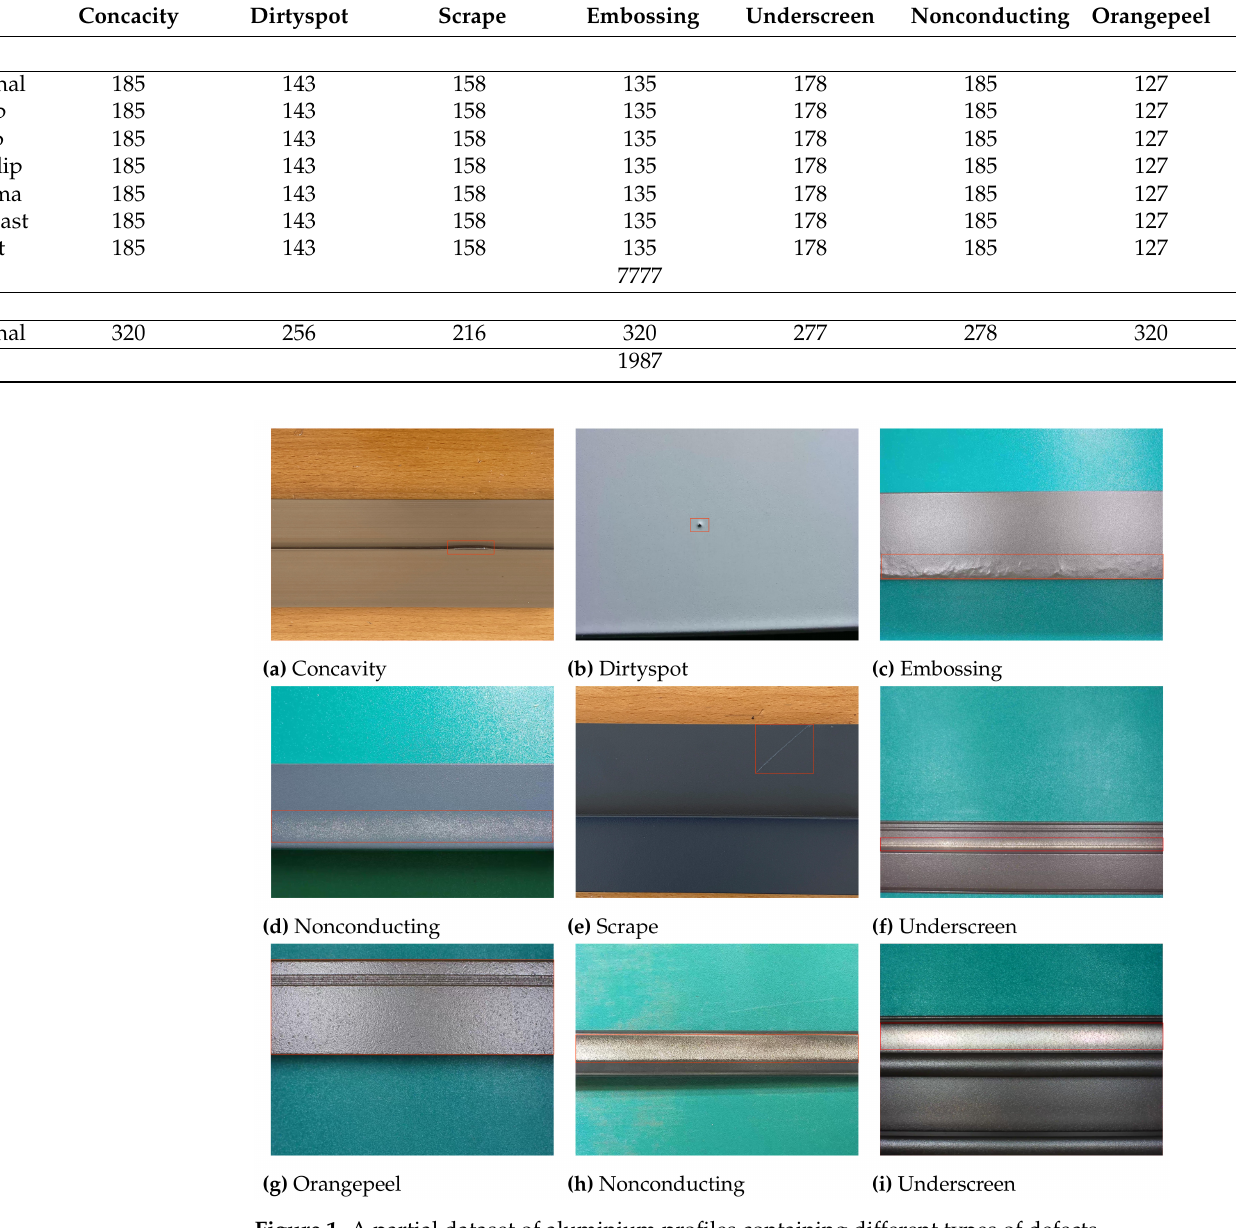
Figure 1. A partial dataset of aluminium profiles containing different types of